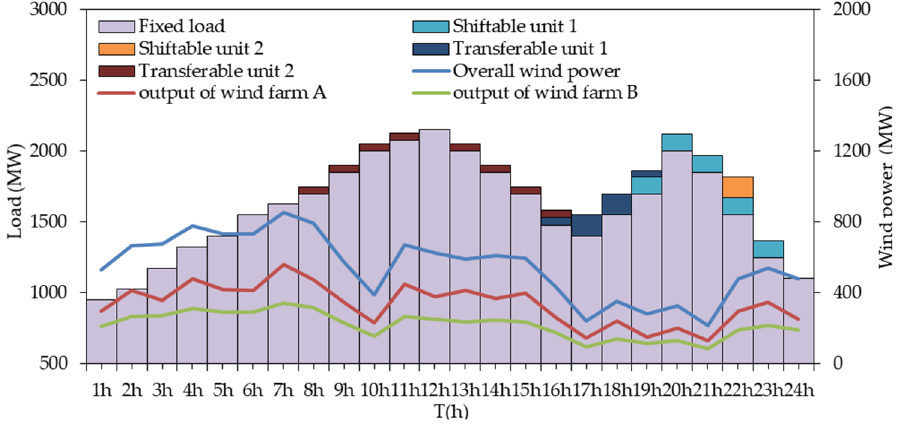
Figure 6. 24-hour basic data.